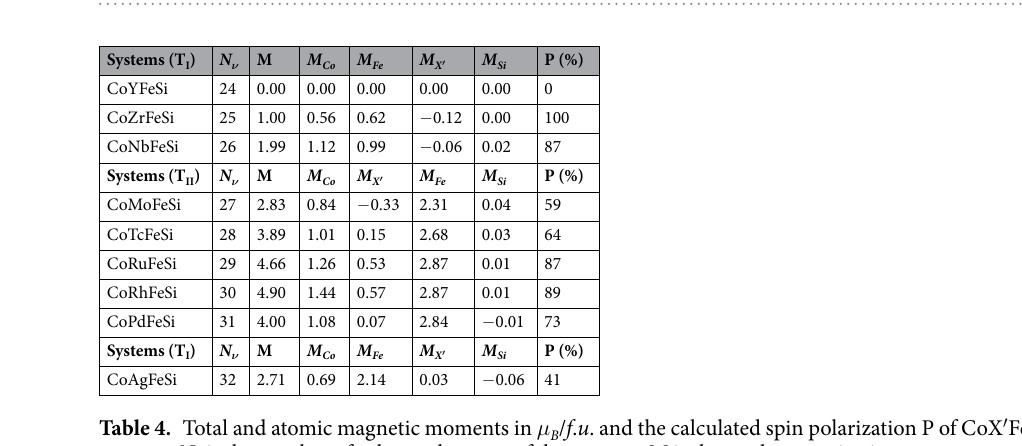
Table 3. Total and local magnetic moments in μ B / f . u . and the calculated spin polarization P of CoX ′ MnSi systems. N ν is the number of valence electrons of the systems. M is the total magnetization.